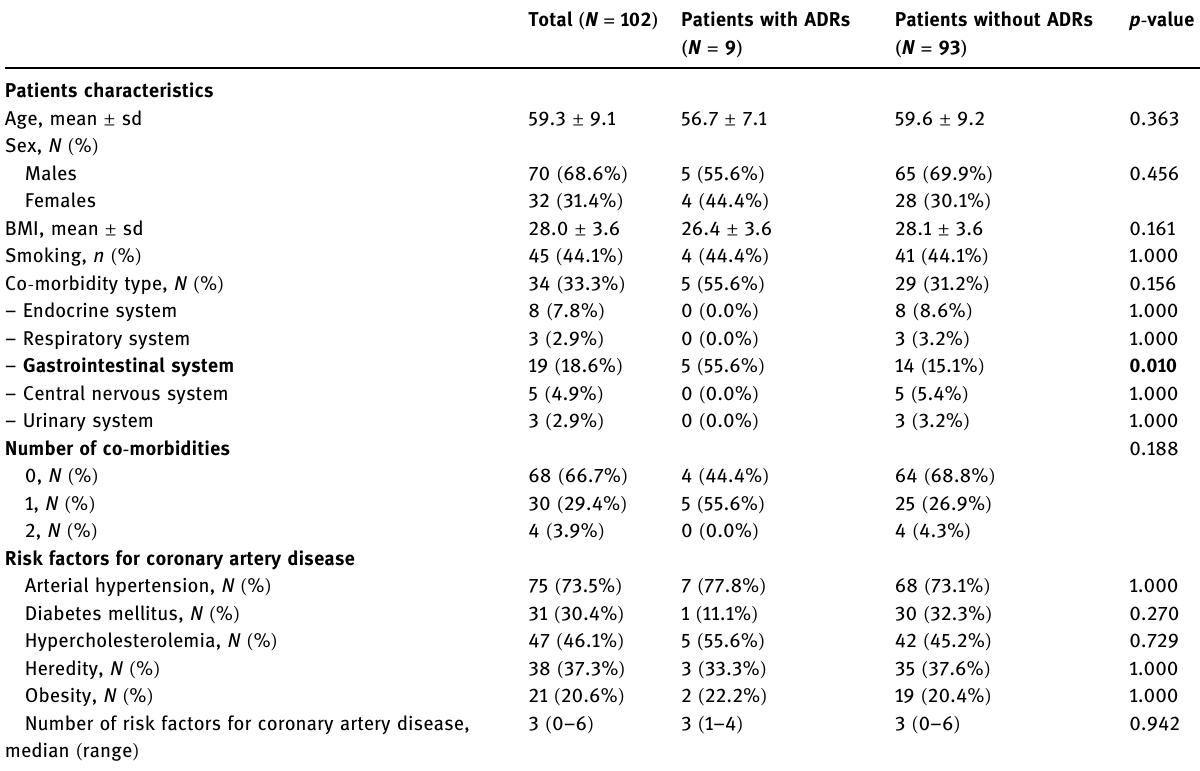
Table 1: Demographic and clinical characteristics of the cardiac disease patients involved in the study